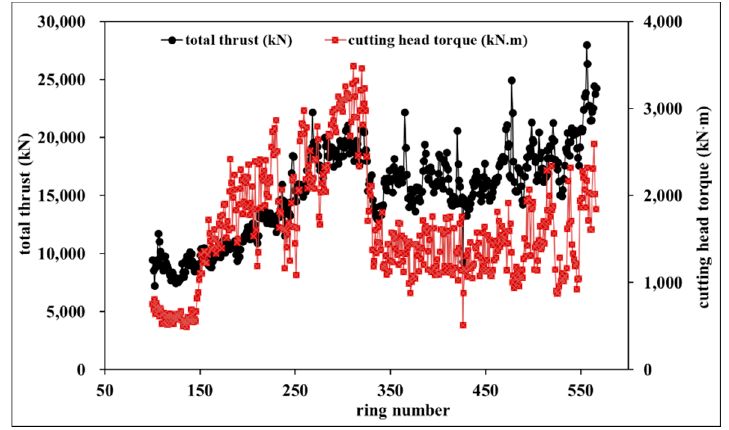
Figure 4. Changes of total thrust and cutting head torque of the machine at the Beijing south-to-north water diversion auxiliary project.